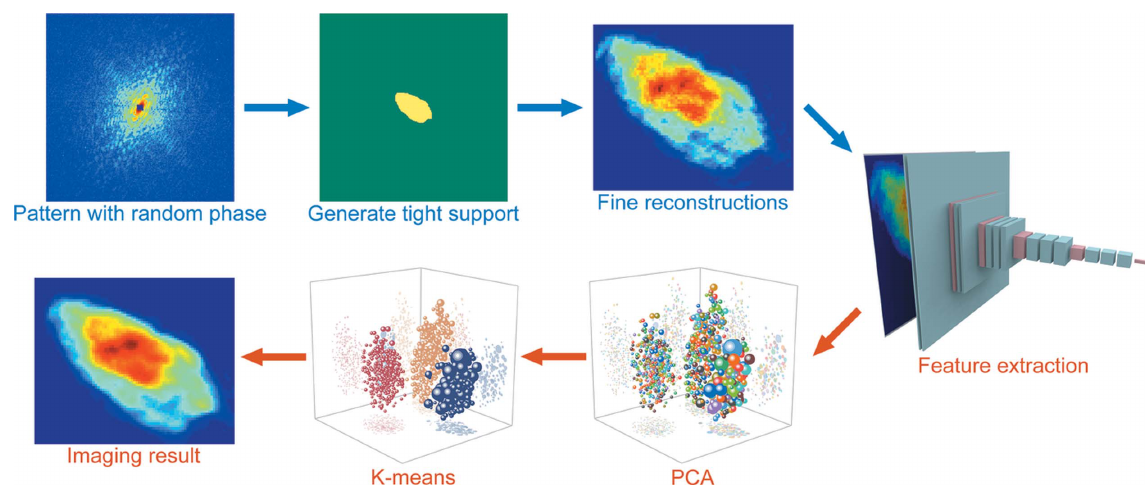
Figure 2 A flowchart of the whole reconstruction. Stages labelled with blue and orange text represent phase retrieval and clustering, respectively.